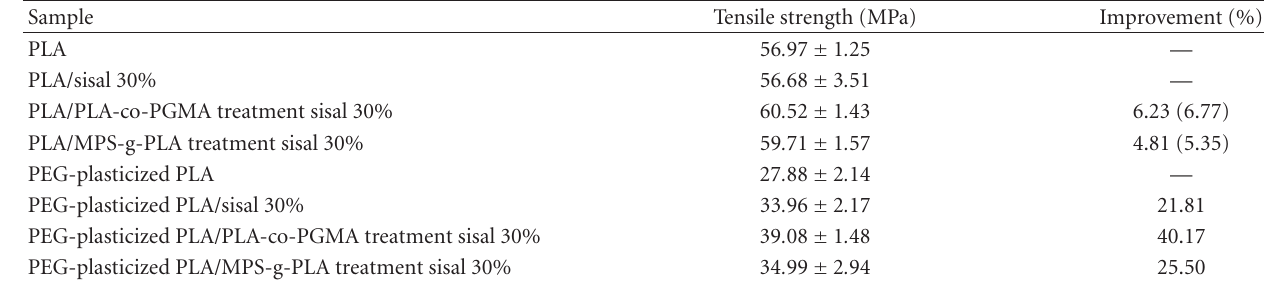
Figure 7: The storage modulus as a function of temperature for PLA and its composites. (a) Storage modulus; (b) The loss factor. Table 1: Tensile properties of PLA and their composites with 30 wt.% sisal